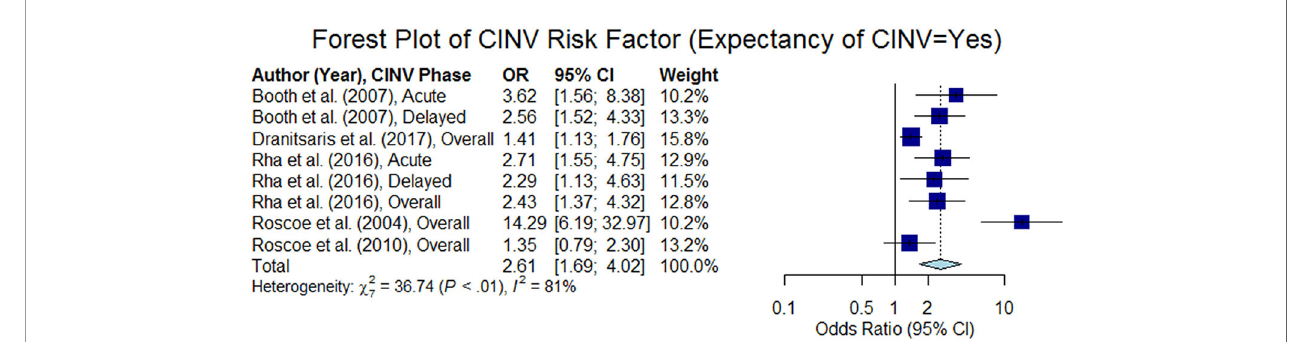
FIGURE 9 | Forest plot of Chemotherapy-Induced Nausea and Vomiting (CINV) risk factor (expectancy of cinv